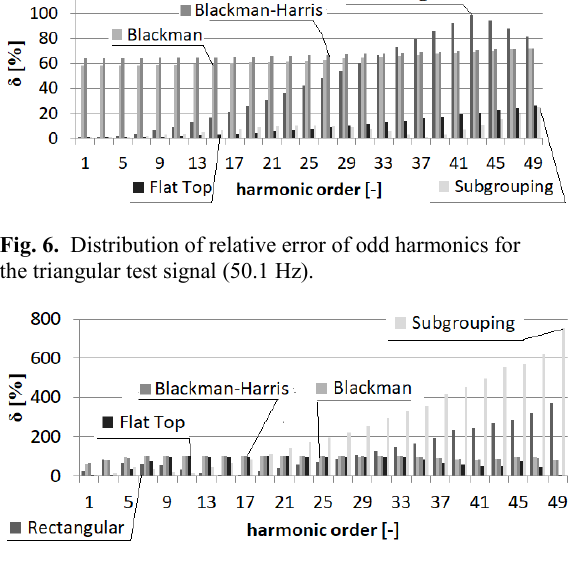
Fig. 7. Distribution of relative error of odd harmonics for the triangular test signal (52